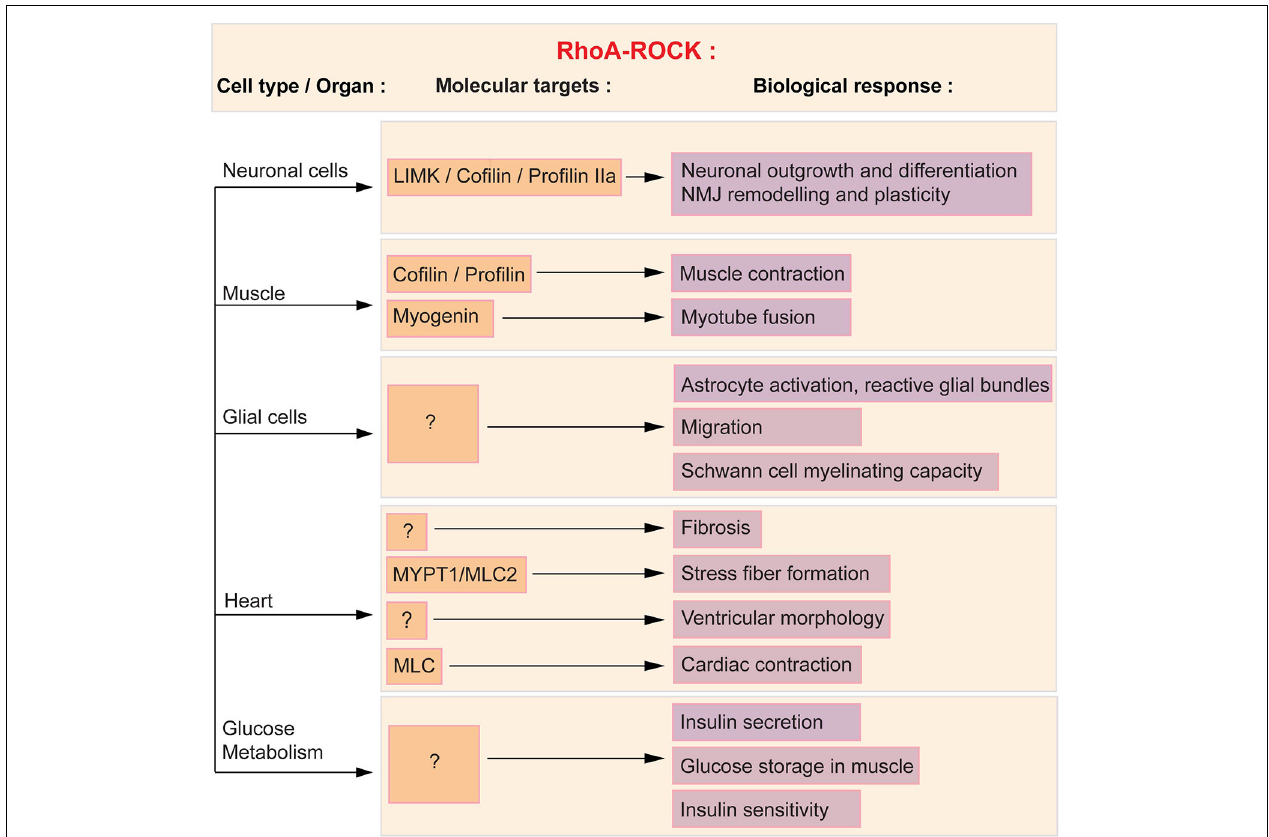
FIGURE 1 | RhoA/ROCK molecular and functional targets in affected SMA cells and tissues. ROCK acts in a variety of cells and tissues via several downstream effectors, of which some are known and described herein (orange boxes) and subsequently linked to the associated cellular process (purple boxes). Cofilin, profilin and LIMK regulate neuronal outgrowth and differentiation as well as NMJ plasticity. Cofilin, profilin and myogenin